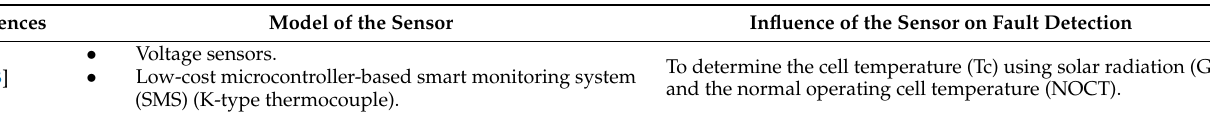
Table 3. Comparisons of various sensors with their configuration used in the experimental